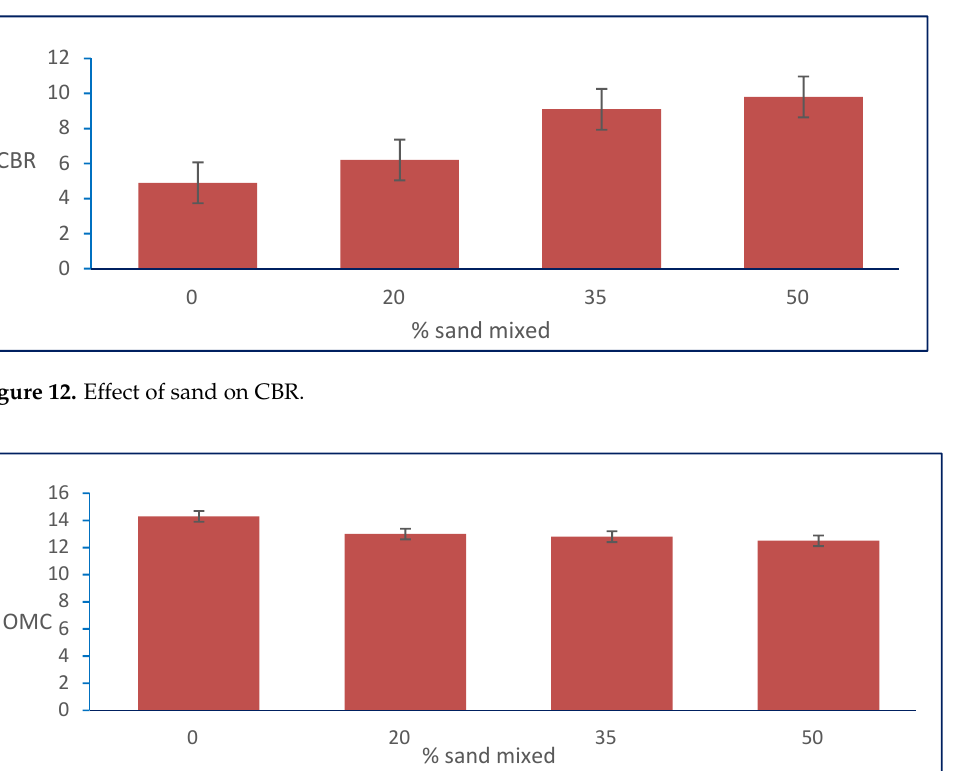
Figure 11. Effect of sand on PI.